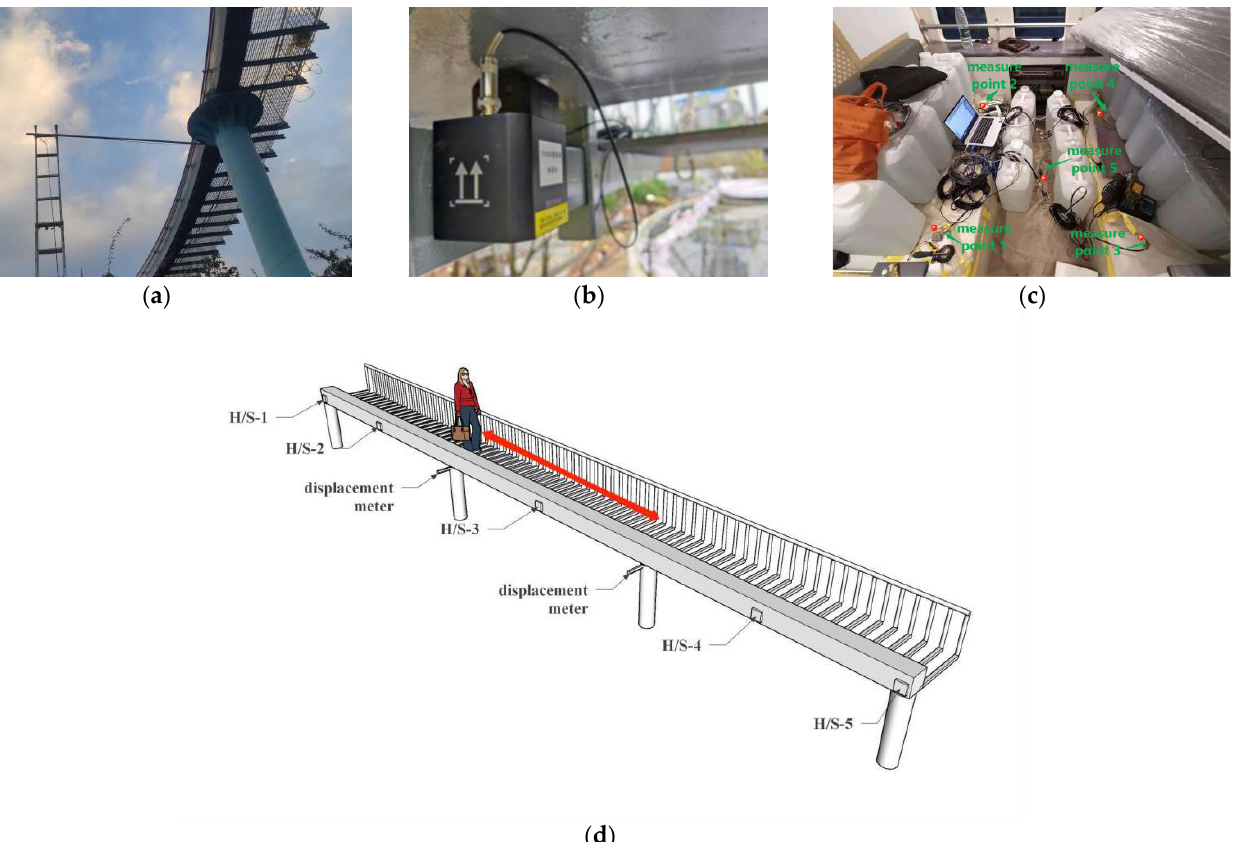
Figure 3. The layout of measuring points. ( a ) Amplitude measuring point; ( b ) vibration sensors; ( c ) vehicle measuring points; ( d ) overview of walking route and measuring points.